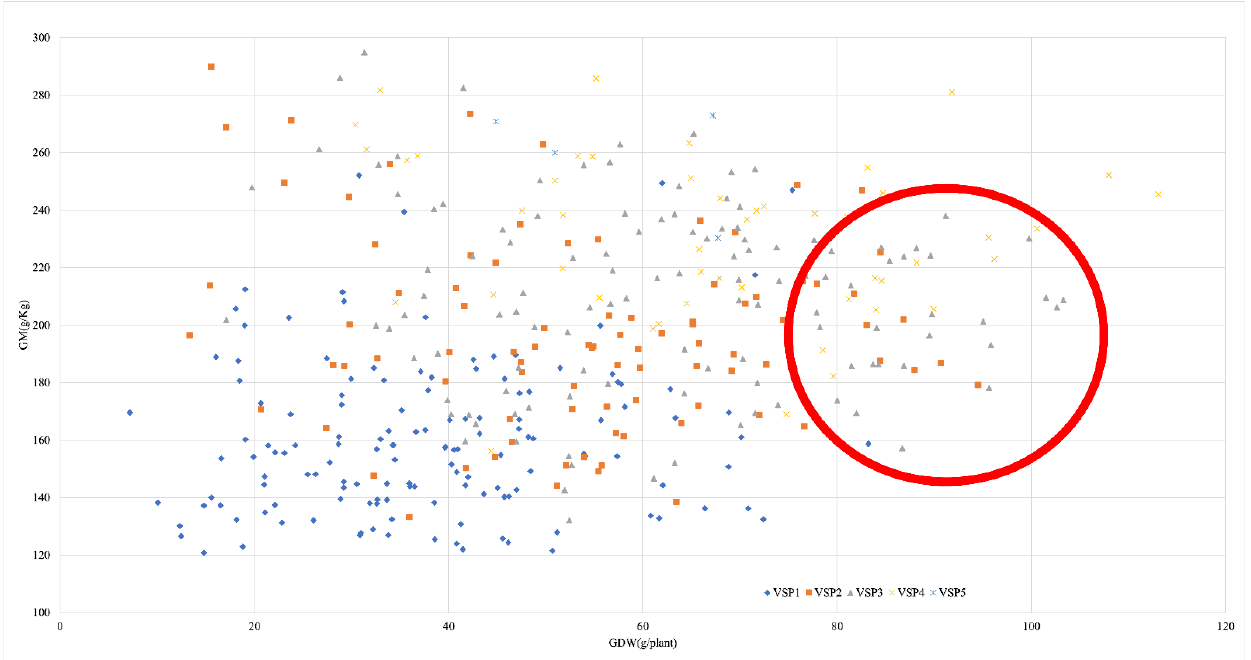
Figure 2. Comparison of early senescence and late senescence genotypes with agronomical traits. GM — grain moisture in grams/plant; GDW — grain dry weight in grams/plant; VSP1 — genotypes correspond to a visual scale of plant value 1 (completely dry) at 45 DAA; VSP2 — genotypes correspond to a visual scale of plant value 2 (partial green) at 45 DAA; VSP3 — genotypes correspond to a visual scale of plant value 3 (intermediate green, intermediate dry) at 45 DAA; VSP4 — genotypes corresponds to a visual scale of plant value 4 (partial dry) at 45 DAA; VSP5 — genotypes corresponds to a visual scale of plant value 5 (complete green) at 45 DAA; Red circle — exceptional genotypes to the relationship between plant visual scale and grain moisture and yield.